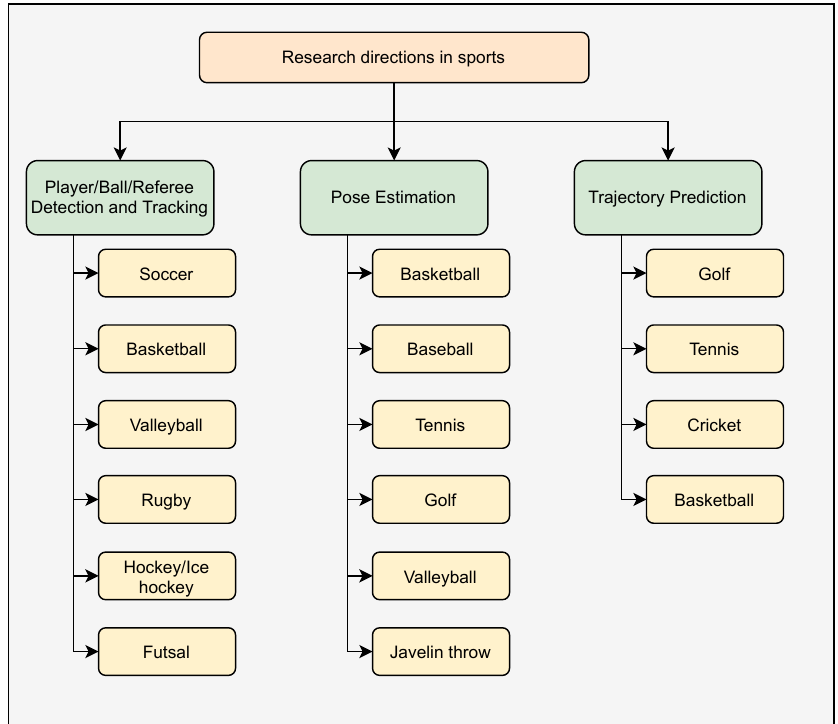
Figure 18. Major task specifics in sports